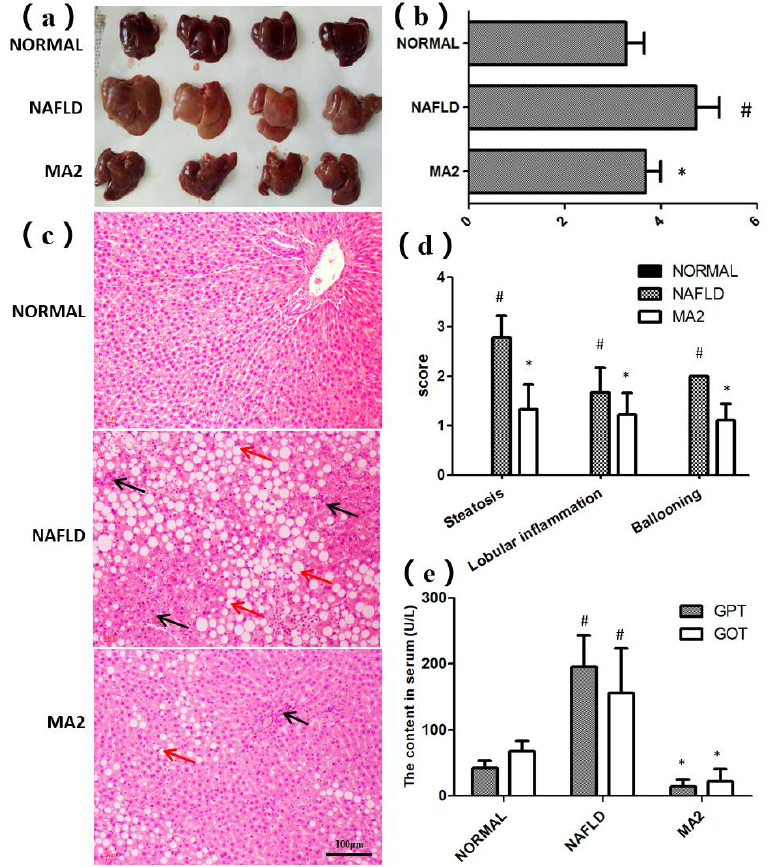
Figure 2. L. plantarum MA2 prevented liver fat accumulation and pathological damage in NAFLD rats. ( a ) Liver appearance, ( b ) liver index, ( c ) morphology of liver tissues (H&E staining). H&E- stained sections revealed macrovesicular and microvesicular steatosis throughout the entire lobules (red arrows), as well as scattered lobular and perivenular inflammation (black arrows). (Original magnification: × 200; Bars = 100 μm). ( d ) Liver histopathology score, ( e ) GPT and GOT activity in serum. The values were presented as mean ± standard error of mean ( n = 8), (# indicates p < 0.05 compared with the normal group; * indicates p < 0.05 compared with the NAFLD group. NORMAL: normal group, NAFLD: non-alcoholic fatty liver disease, MA2: L. plantarum MA2 treatment group).